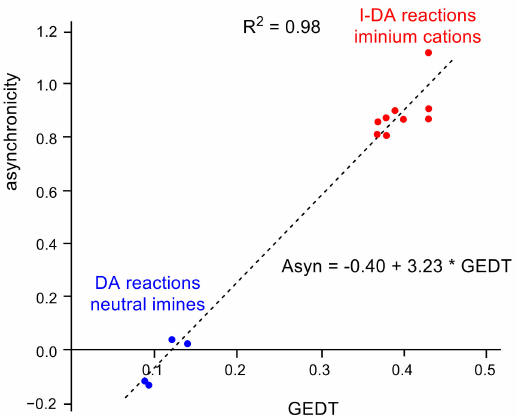
Figure 6. Plot of the asynchronicity, Asyn = (l1–l2) in Angstroms, vs. the GEDT, in e, taking place at the TSs associated with the DA reaction of non-symmetric imines and the I-DA reaction of non- symmetric iminium cations.